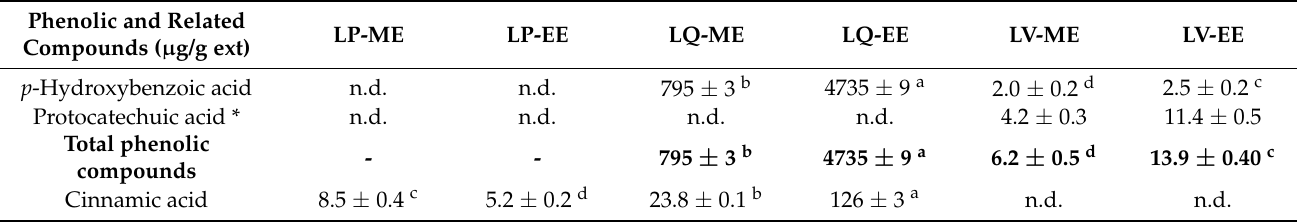
Table 4. Phenolic and related compounds of the extracts of the studied mushrooms (mean ± SD, n =